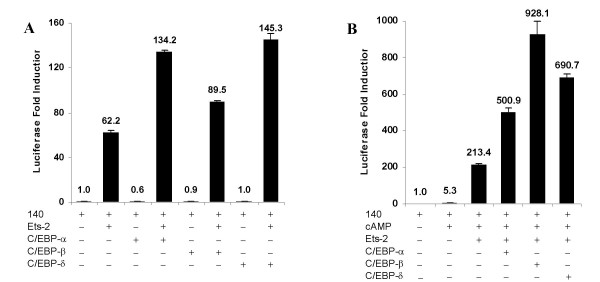
Effects of C/EBP-α, -β and -δ on the Tkdp-1 140 bp promoter activity in JEG-3 cells. Luc expression driven by the minimal promoter in cells co-transfected with each of the C/EBP isoforms A) in the absence and presence of over-expressed Ets-2 and B) in the presence of over-expressed Ets-2 and 250 μM 8-BrcAMP. Luc activities are expressed relative to that of the basal activity of the 140 bp promoter and data are shown as mean ± SEM (n = 3). The following values are significantly different at P < 0.05: A) 140 vs. Ets-2, C/EBP-α+Ets-2, C/EB-Pβ+Ets-2, C/EBP-δ+Ets-2 and B) 140 vs. cAMP+Ets-2, cAMP+Ets-2+C/EBP-α, cAMP+Ets-2+C/EBP-β, cAMP+Ets-2+C/EBP-δ; cAMP+Ets-2 vs. cAMP+Ets-2+C/EBP-β, cAMP+Ets-2+C/EBP-δ. cAMP+Ets-2+C/EBP-β is significantly different (P < 0.05) from both cAMP+Ets-2+C/EBP-α and cAMP+ Ets-2+C/EBP-δ.